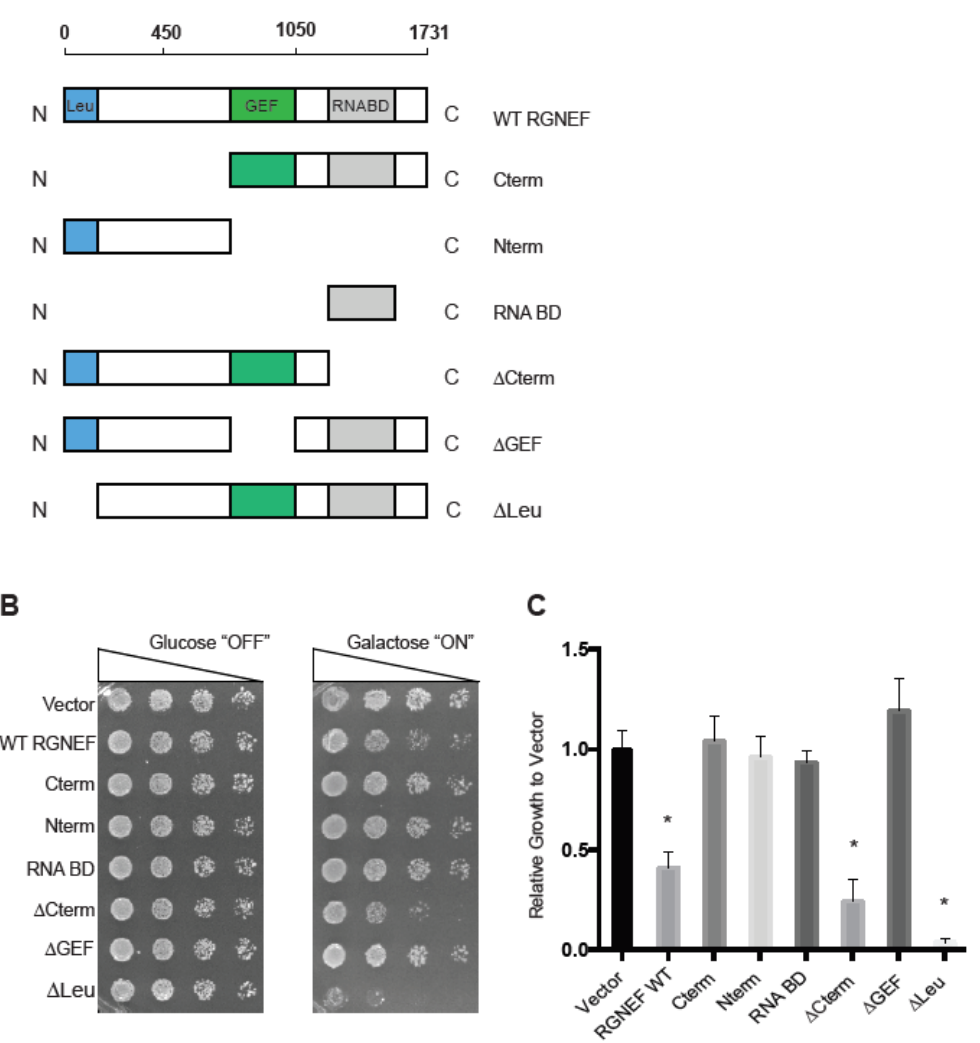
Figure 1. Rho guanine nucleotide exchange factor (RGNEF) toxicity in yeast. ( A ) RGNEF WT (full length, wild type) and domain-deleted truncations are illustrated. ( B ) Yeast growth assay of RGNEF WT and mutants. Cells were plated on non-inducing and inducing agar plates in one to five serial dilutions to observe the growth phenotype associated with expressing each variant (left). ( C ) Results as shown in B were quantified and normalized to growth of the control cells (vector). Error bars represent standard deviations. One way analysis of variance, Tukey post hoc show statistical significance (*) of reduced growth for RGNEF WT ( p < 0.05), ∆ Cterm ( p < 0.05), and ∆ Leu ( p < 0.01) compared to controls.